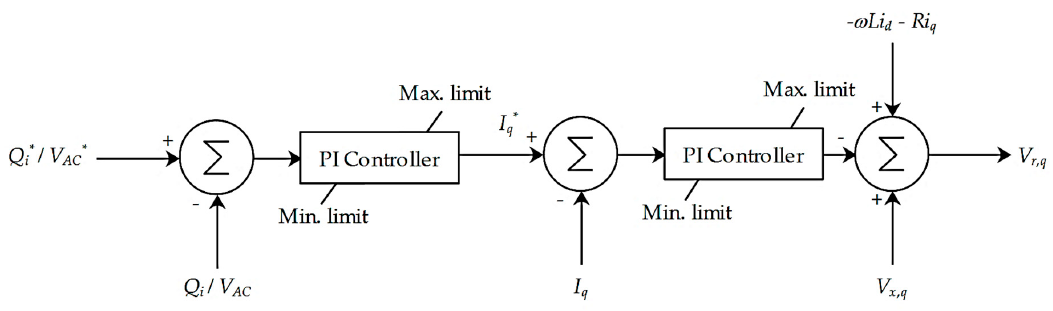
Figure 4. The complete block diagram of the reactive power flow and AC voltage controllers.